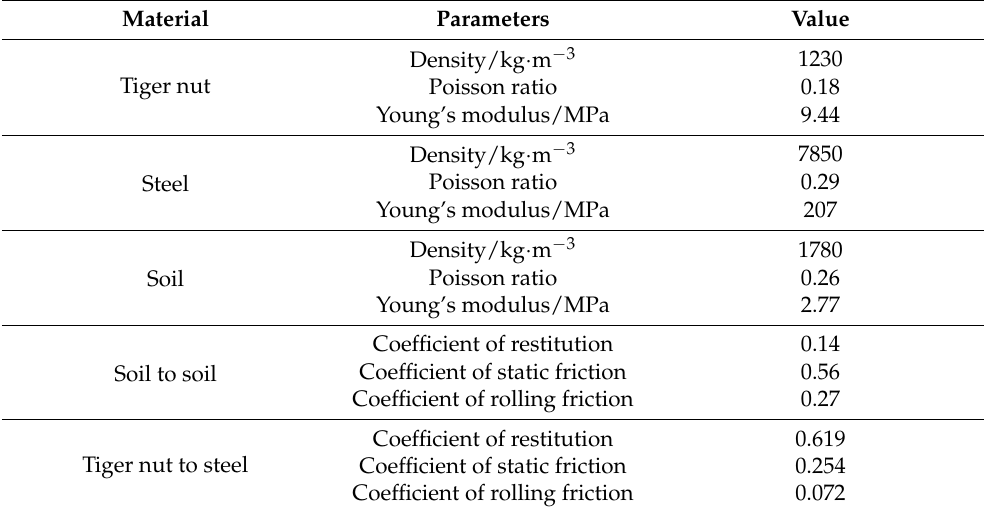
Table 2. Simulation test parameters of tiger nuts. Material